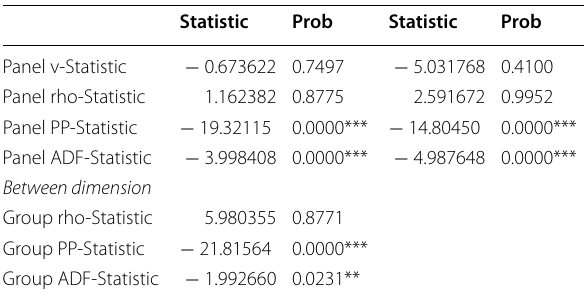
Table 4 revealed that the Pedroni panel co-integration results revealed that six (6) of eleven (11) of the Pedroni statistics significantly reject the null of co-integration.